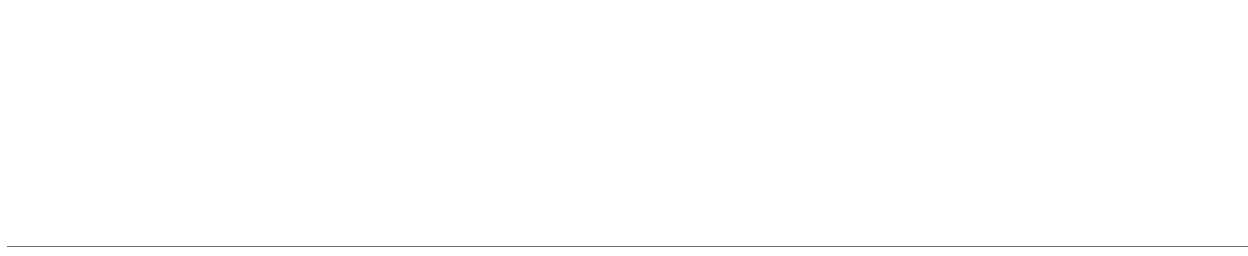
Frontiers in Chemistry |